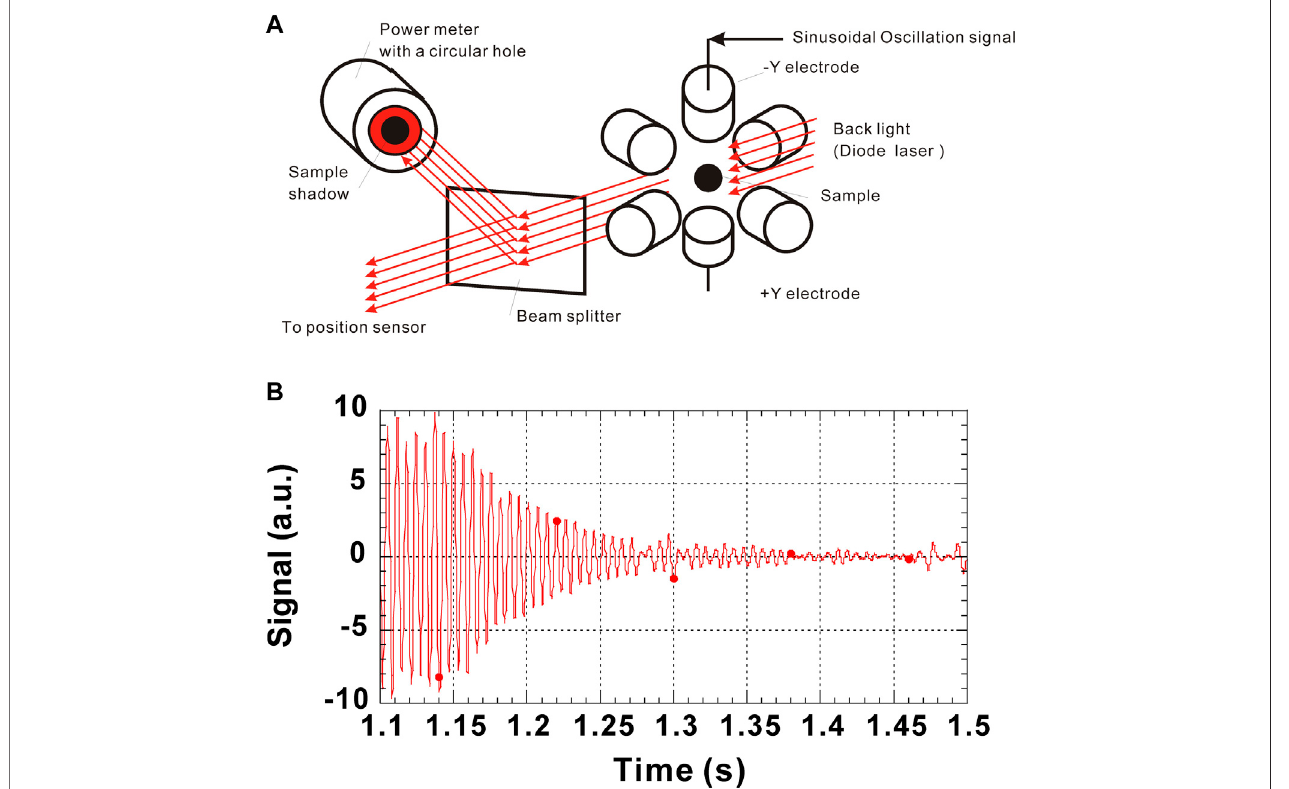
FIGURE2| DroposcillationsystemoftheISS-ELF: (A) Schematicdrawingofhowtoexciteandobservedroposcillations; (B) Atypicaloscillationsignalobtainedby the power meter.